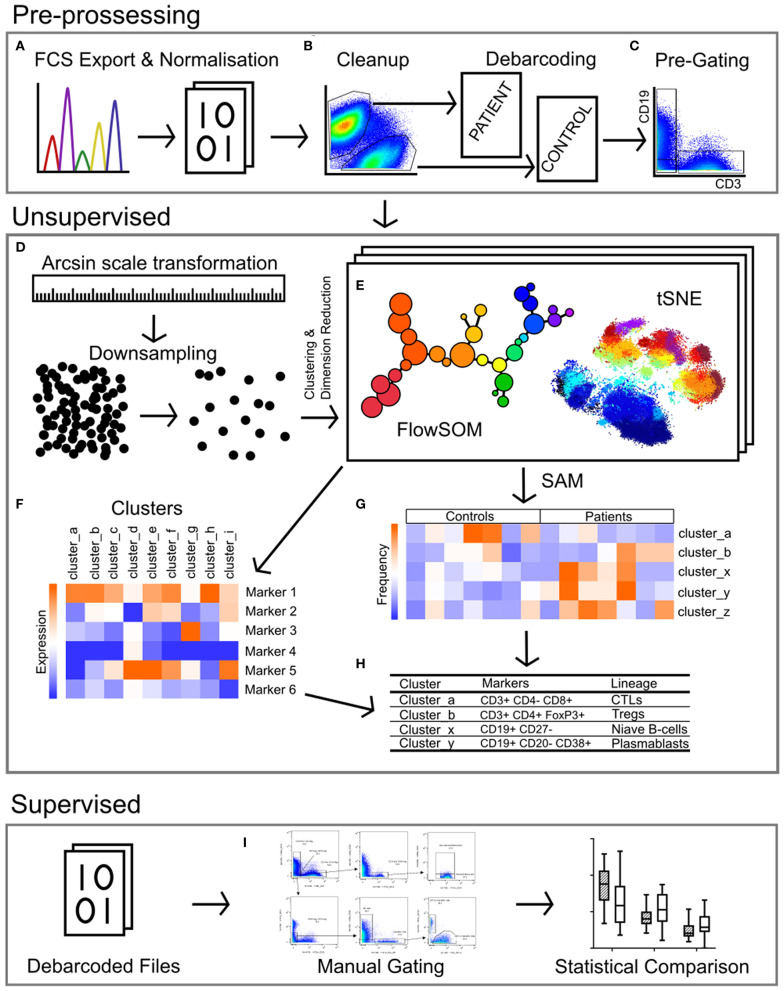
Pipeline for the analysis of mass cytometry data. (A) Raw files acquired from the Helios mass cytometer were normalized based on the signal intensity of bead-specific isotopes, and exported as FCS files. (B) Files were manually cleaned to identify intact cells based on Ir_191 DNA staining, beads removed based on bead specific Ce_140, and doublets excluded using Ir_191 DNA staining vs. event length. Patient and control samples were debarcoded and exported into separate files based on staining with CD45-Pd_104 (patients) and CD45-Pd_108 (controls). Live cells were identified based on cisplatin stain intensity. (C) Events were pre-gated on CD3 vs. CD19 to export files containing T-cells (CD3+ CD19-), B-cells (CD19+ CD3-) and non-T-non-B cells (CD3- CD19-, i.e., monocytes, dendritic cells, NK cells). (D) The signal intensity of each marker was transformed by arcsin scaling and events from each individual were downsampled then concatenated for clustering analysis. (E) T-cells, B-cells, and non-T-non-B-cells were clustered separately by FlowSOM and visualized by t-stochastic neighbor embedding (tSNE). This was repeated multiple times with cluster numbers ranging from 40 to 90, in order to determine the most appropriate number of clusters (F) based on marker expression. (G) Significance analysis of microarrays (SAM) was used to identify clusters with different frequencies between patients and controls (H), and the lineage of these clusters was determined based on the expression of markers (F). (I) Binary gating was employed to manually investigate previously characterized PBMC subpopulations, and to further investigate events corresponding to clusters identified in unsupervised analysis.